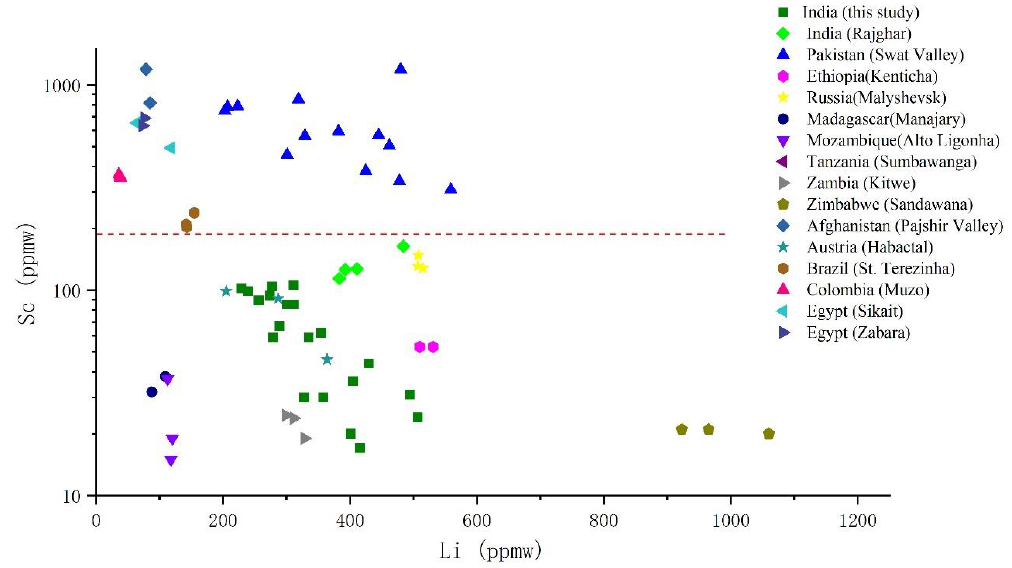
Figure 15. A log plot of lithium (Li) versus scandium (Sc) concentrations in emeralds from sixteen deposits. Data are expressed in ppmw. Sources of data are the same as Figure 14.